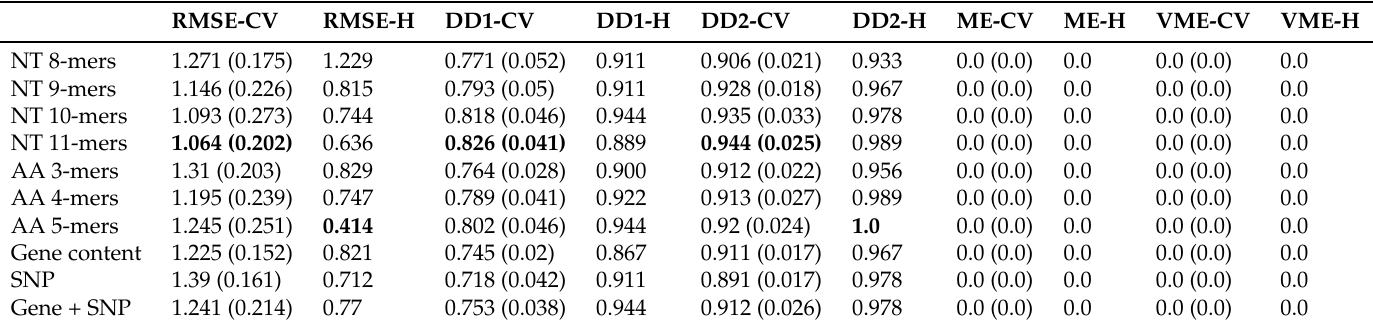
Table A29. N. gonorrhoeae –azithromycin.